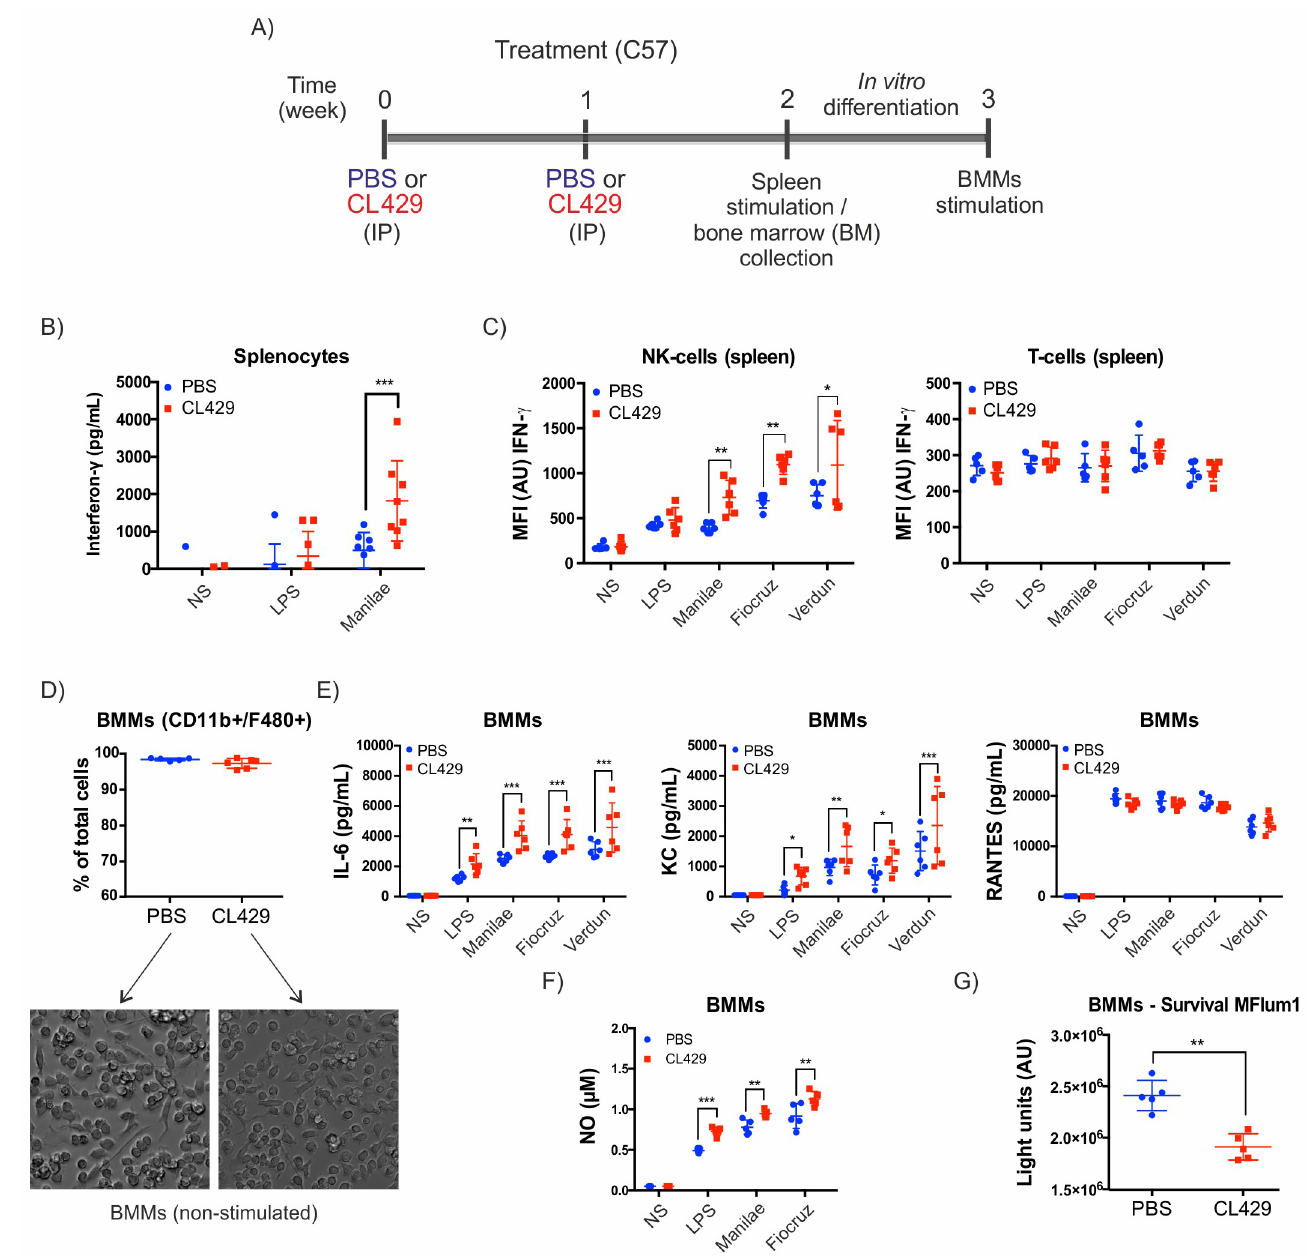
Fig 5. CL429 treatment leads to a systemic enhanced antileptospiral response. A) Chronogram of the experiment. C57BL/6 WT mice were injected IP with 200 μ L PBS containing 2.5% DMSO (vehicle) or 25 μ g CL429 2 and 1 weeks before the collection of splenic and bone marrow cells for cytometry staining, macrophage differentiation and ex vivo stimulation. Splenic cells were plated and exposed for 24 h to 100 ng/mL E . coli LPS or live Leptospira interrogans serovar Manilae, Fiocruz or Verdun at a MOI of 100. Bone marrow cells were differentiated into bone marrow-derived macrophages (BMMs) for 7 days, plated and stimulated with LPS or live leptospires. B) Interferon(IFN)- γ IFN production in the supernatant of splenic cells 24 h post-stimulation assessed by ELISA. Data correspond to 2 independent experiments pooled with n = 4 mice per group, treated individually. C) Flow cytometry analysis of IFN- γ produced by splenic NK and T cells at 24 h post-stimulation. Data correspond to one experiment with n = 6 female mice. D) Flow cytometry analysis of BMMs 7 days post-differentiation of bone marrow cells (upper panel) and representative microscopy images of BMMs showing no major morphological differences in BMMs from PBS- or CL429-treated mice (lower panel). E) Pro-inflammatory cytokine (IL-6) and chemokine (RANTES and KC) profiles determined by ELISA on the supernatant of cells 24 h post-stimulation. F) Nitric oxide (NO) production by BMMs at 24 h after stimulation assessed by the Griess reaction. G) Survival of L . interrogans serovar Manilae bioluminescent strain MFlum1 in contact with BMMs assessed by bioluminescence measurement in culture 24 h post-infection. (D-G) Data are representative of 2 independent experiments with n = 5 mice per group, treated individually. Statistical analysis was performed by the unpaired t -test comparing PBS vs CL429 for each secondary stimulation. � p -value < 0.05; �� p -value < 0.01; ��� p -value < 0.001.